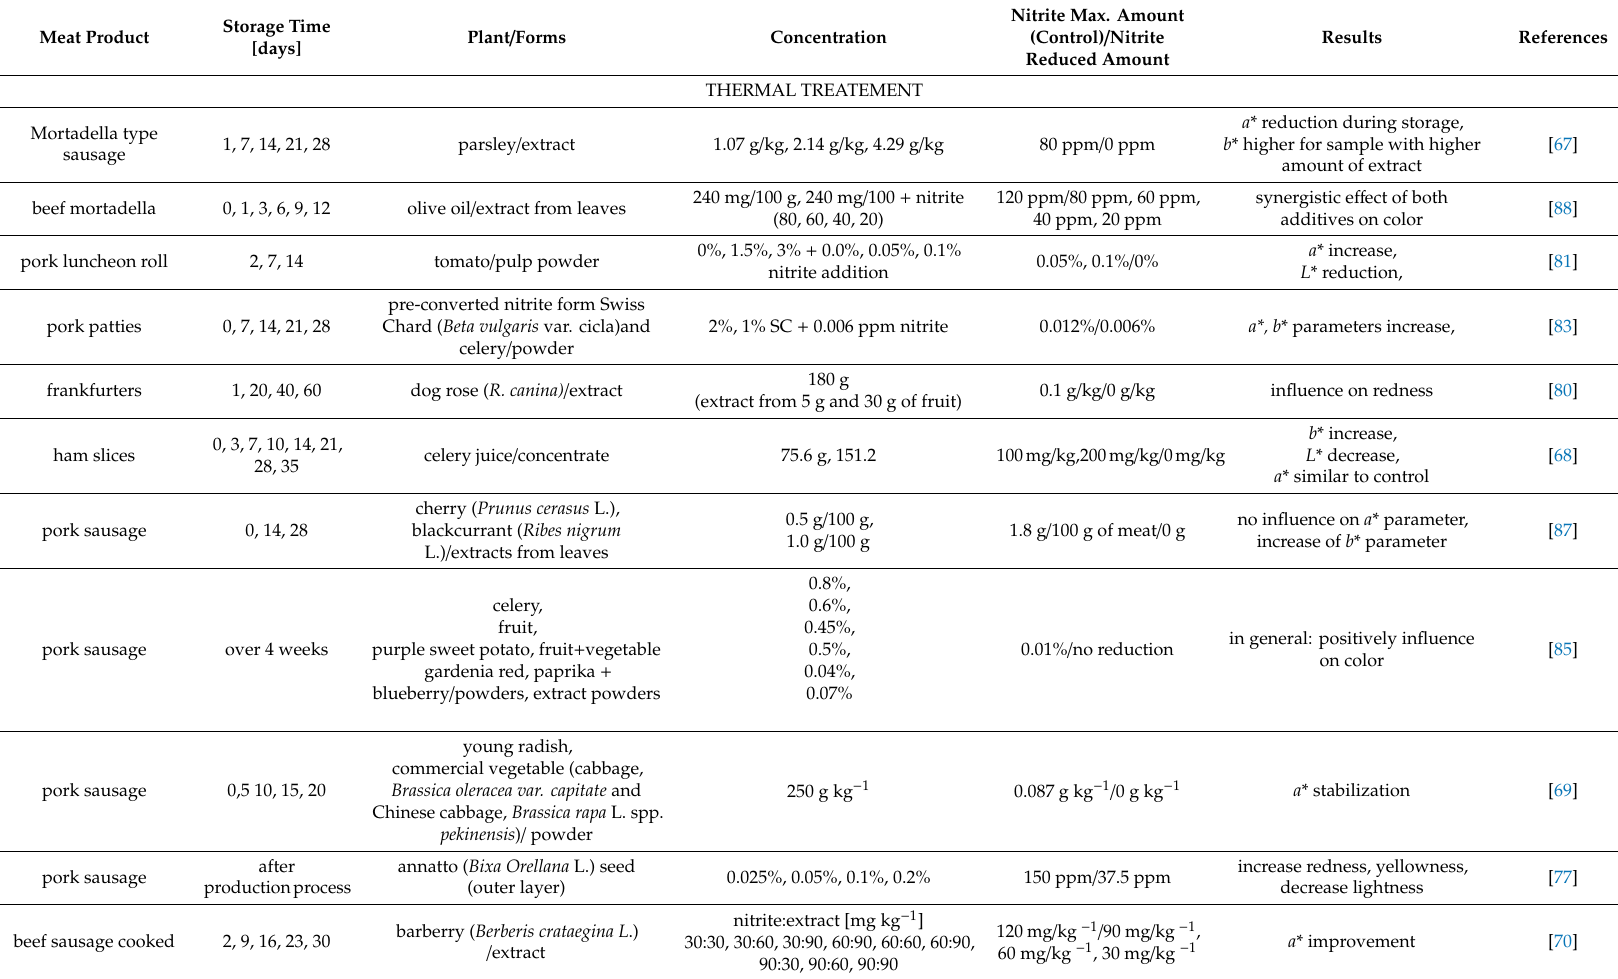
Table 2. Application of plant extracts as a natural coloring agent in meat products with a reduced quantity of